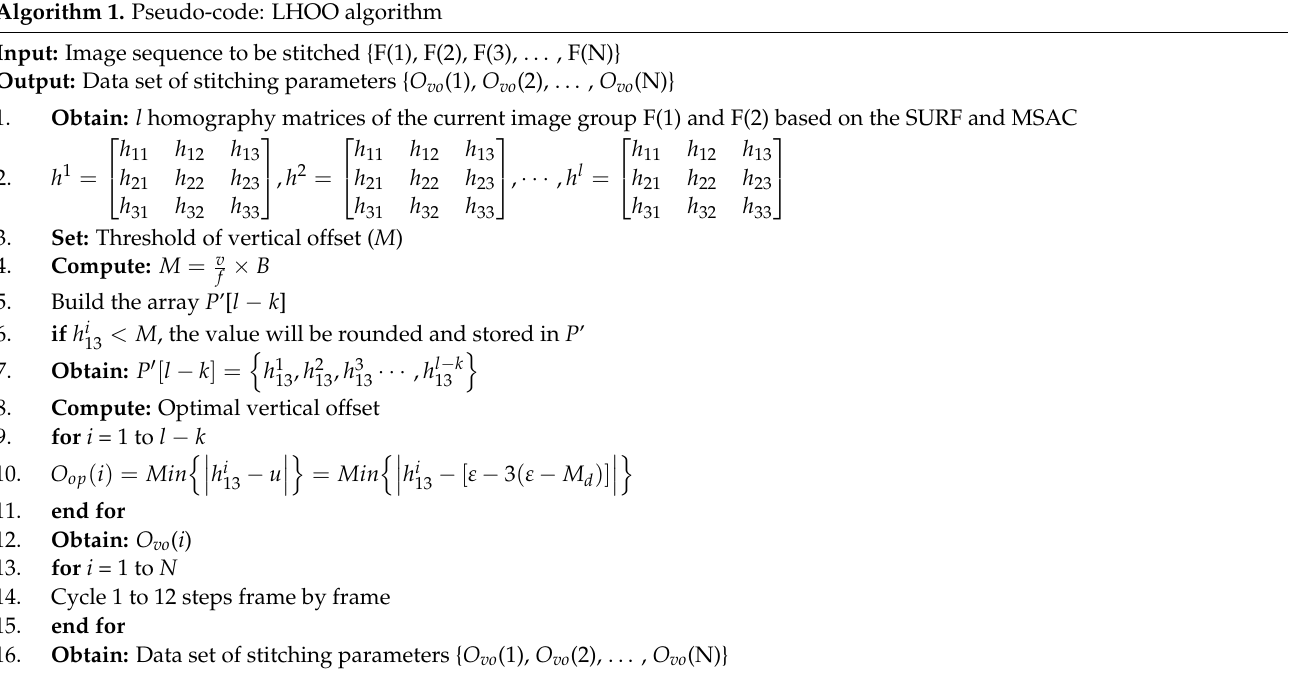
Algorithm 1. Pseudo-code: LHOO